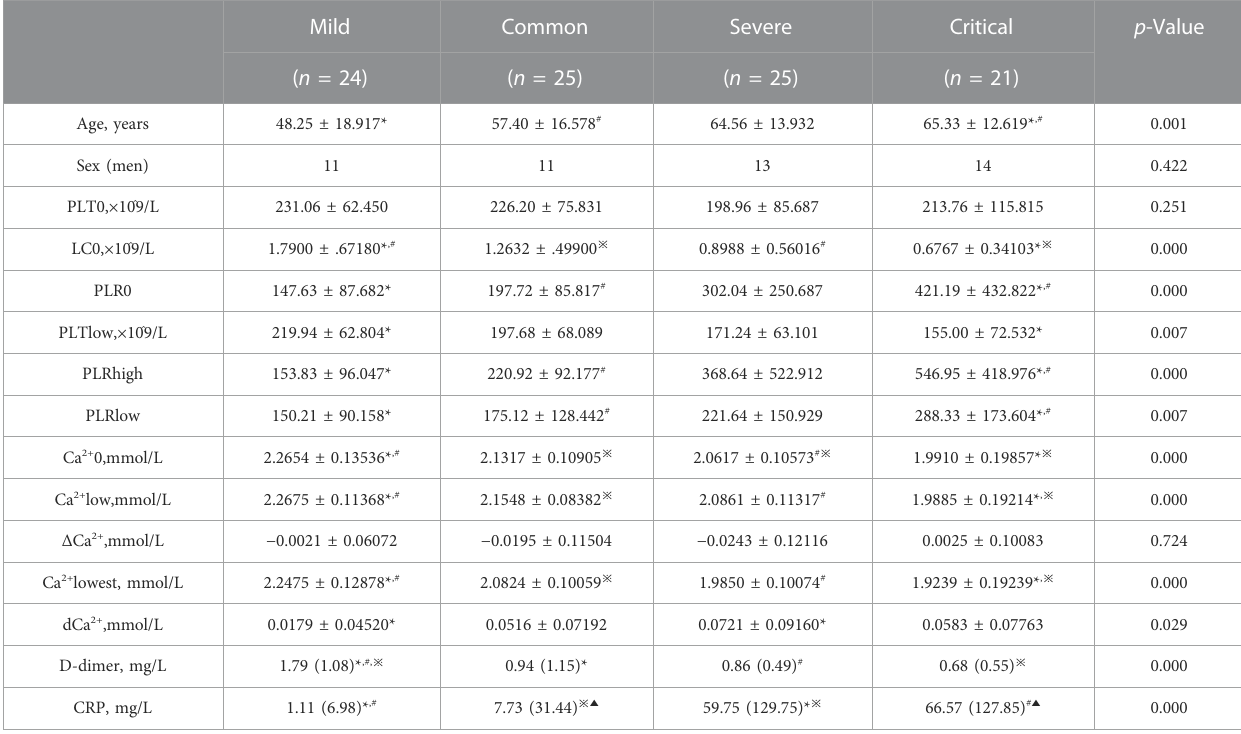
TABLE 1 Demographic characteristics and laboratory parameters of patients of different severities.